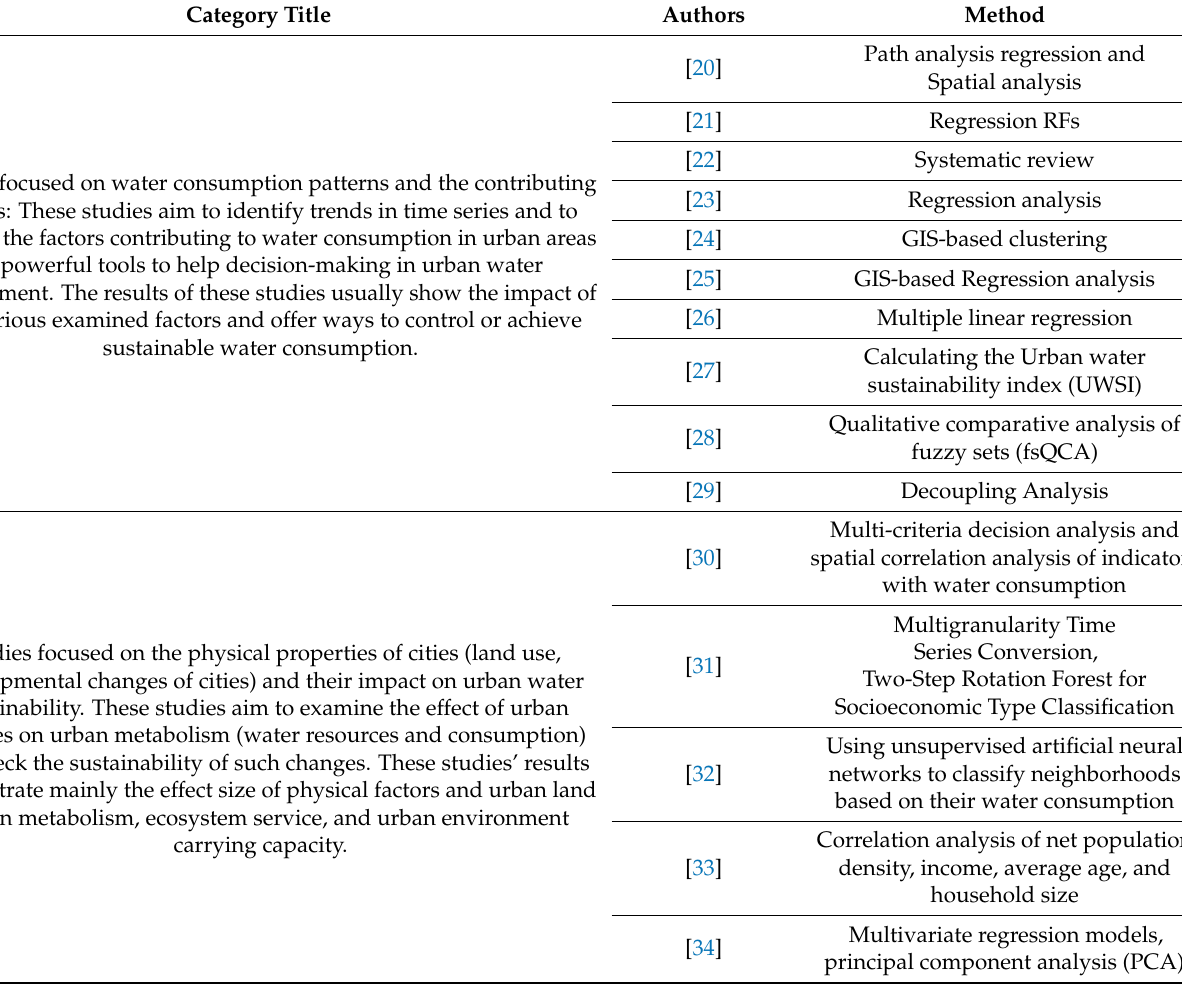
Table 1. Methods and techniques applied in urban water consumption